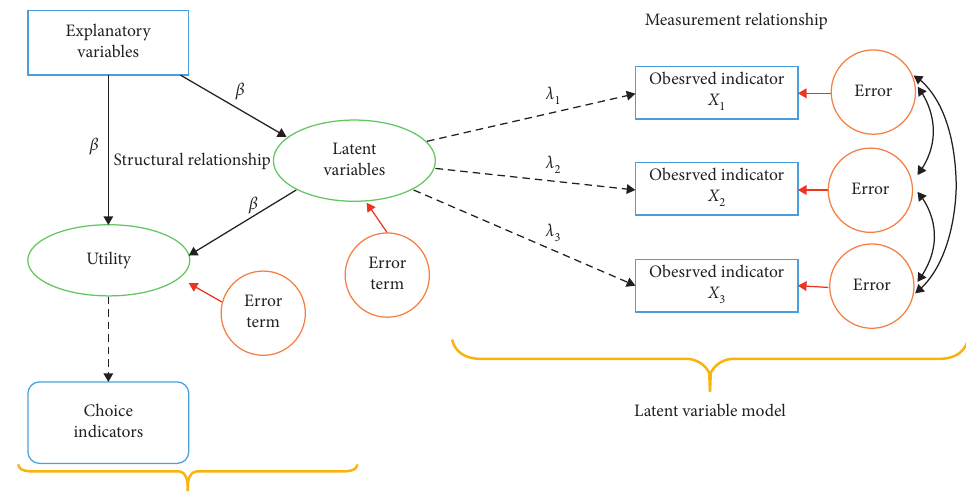
Figure 1: Diagram of a hybrid choice model